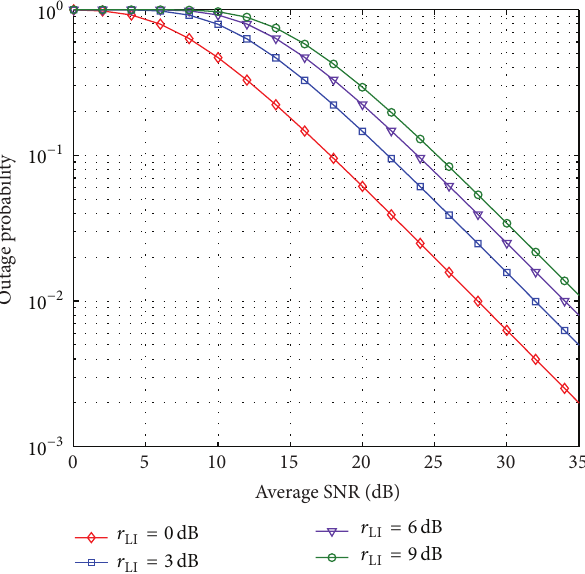
Figure 4: Outage probability of FD mode with different loop interference, when 𝑟 = 5 dB and th